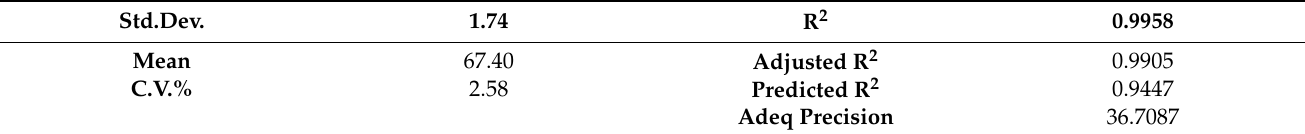
Table 9. Fit statistics of the wear